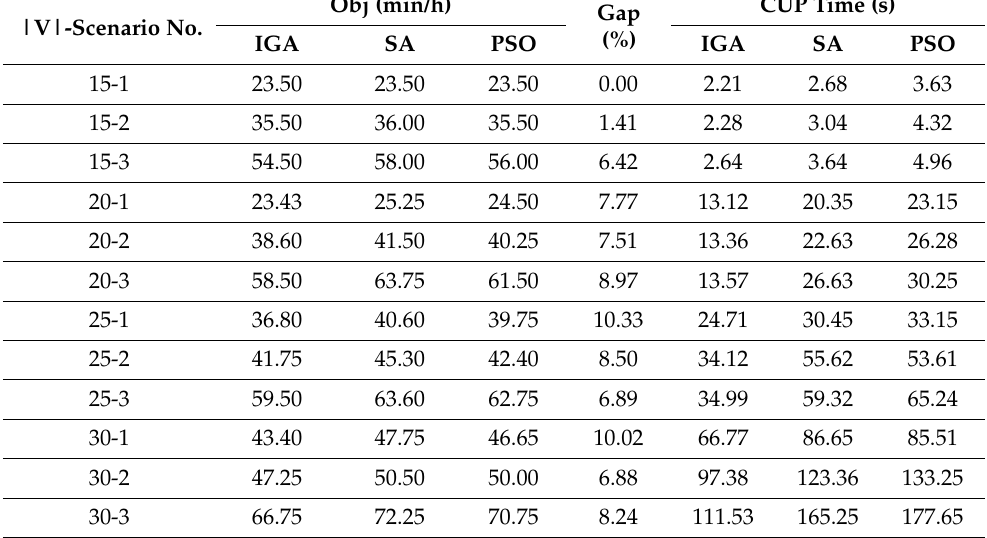
Table 4. Comparison results with SA and PSO.